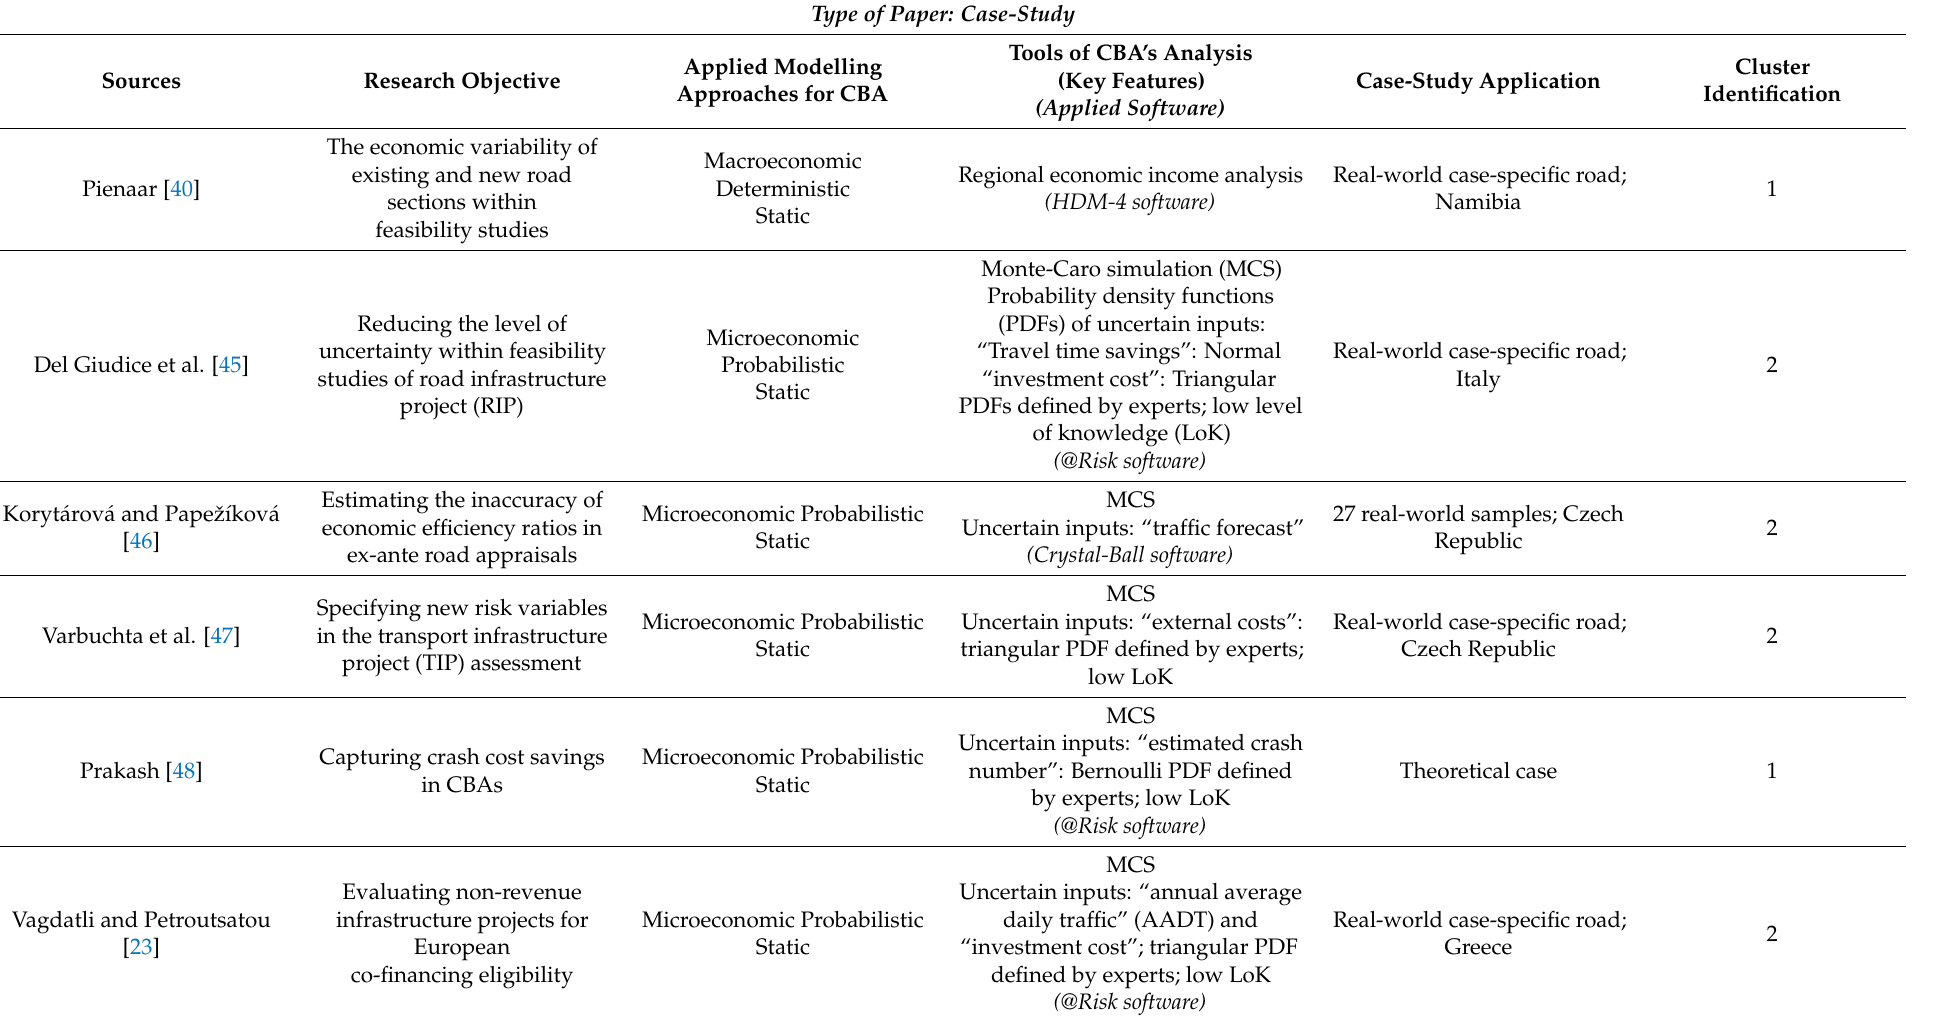
Table 2. Overview of the structured articles extracted from Web of Science (WoS) and Scopus for cost–benefit analysis (CBA) in the road infrastructure sector. Type of Paper: